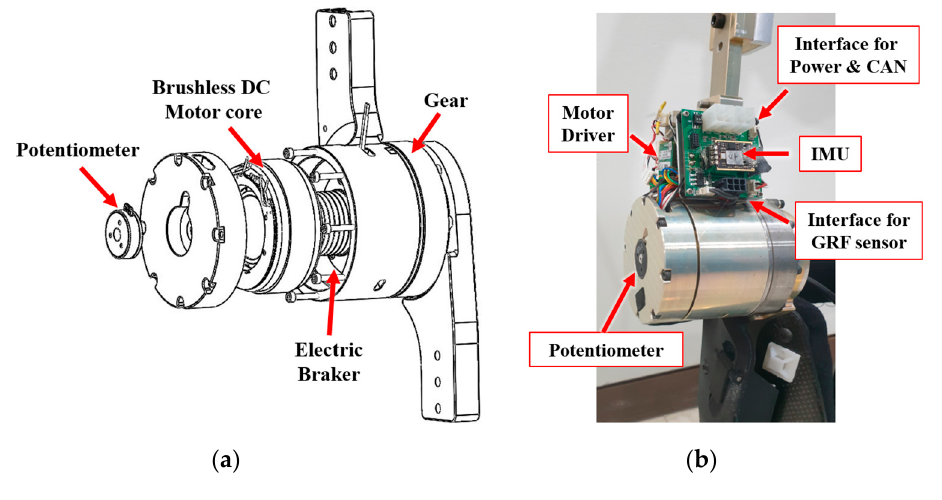
Figure 3. The developed knee actuation module. ( a ) Mechanical design of the knee actuator, and ( b ) the manufactured actuator module and low-level motion controller with sensor interface. Table 1. Specifications of the developed knee actuation module. Table 1. Specifications of the developed knee actuation